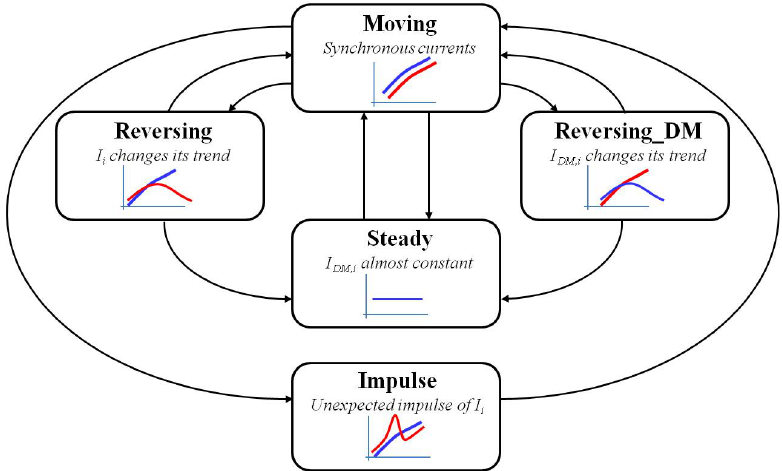
Figure 6. FSM scheme with the sketch of the currents behavior in the various states ( I i in red and I DM , i in blue).